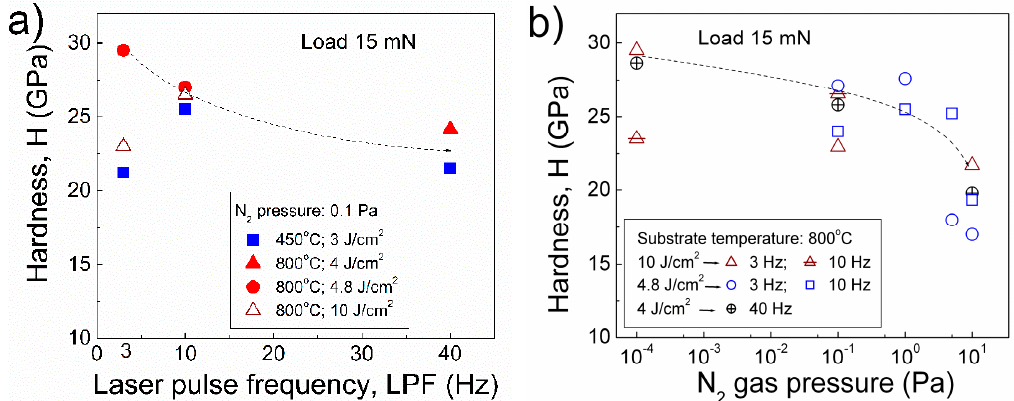
Figure 3. Nanohardness as a function of laser pulse repetition frequency ( a ) and N 2 gas pressure ( b ) for PLD AlN films deposited with variation of other PLD parameters (as given in the insets).